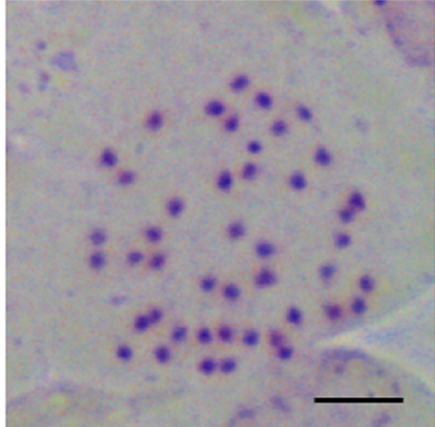
Figure 1. Chromosome spread of tetraploid cell observed under magnification of 100x, showed N. cadamba with 44 chromosomes (Bar =